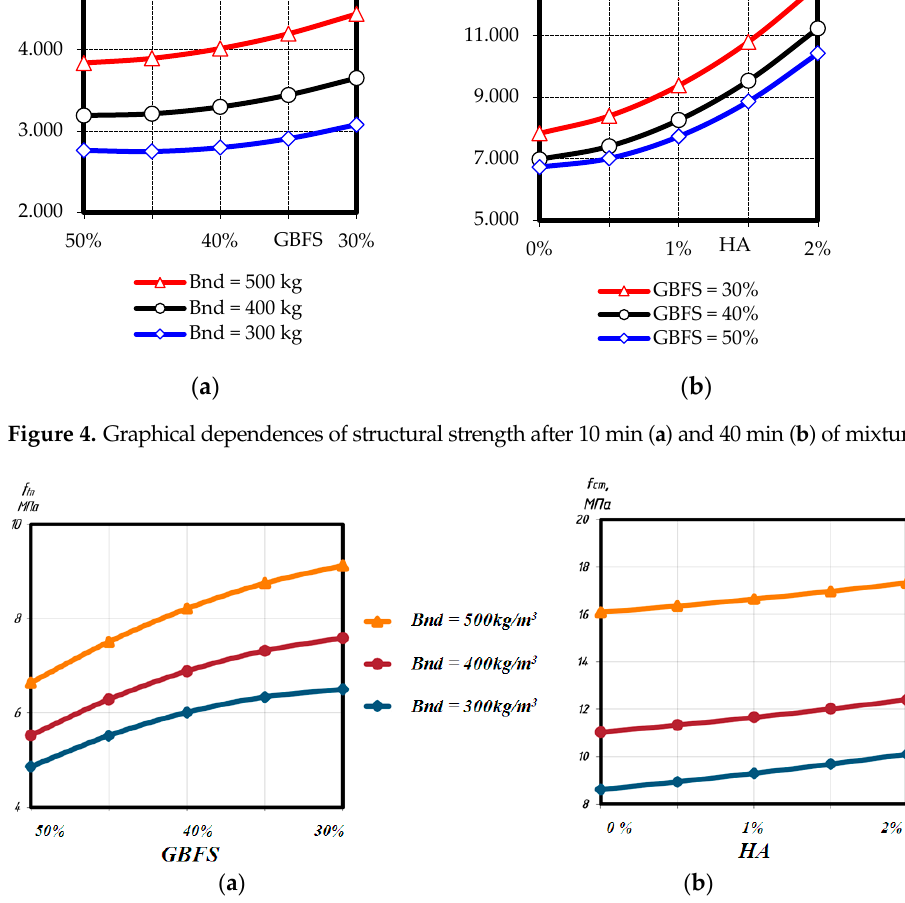
Figure 5. Graphical dependences of the compressive strength of concrete mixtures at the age of 3 days ( a ) and 28 days ( b ).